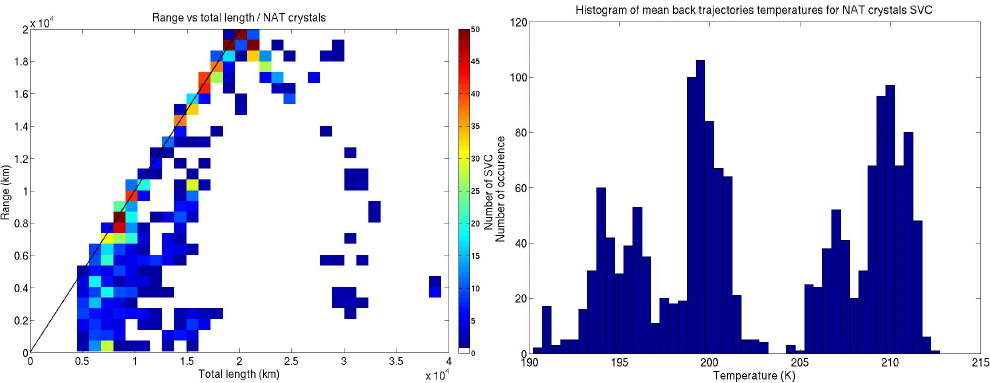
Fig. 11. Distribution of total trajectory length vs. reach away from the SVC (left column) and histograms of mean temperature along the Fig.%12 back-trajectory (right column), for C1 SVC with depolarization ratios between 0.05 and 0.25.